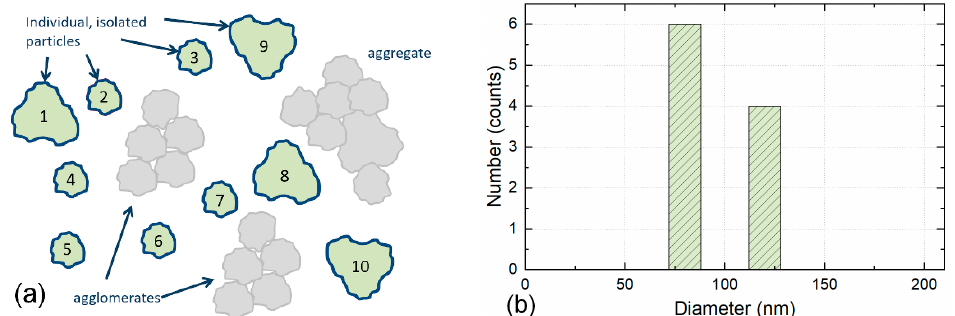
Figure 2. Illustration of Counting Rule 1. ( a ) The particles 1 to 10 are individual particles, without an internal structure that could identify them as agglomerates or aggregates. Only those 10 particles are counted, agglomerates and aggregates (grey) are excluded. ( b ) For the sake of illustration, we assume here only two different types of individual particles, with a size of 80 nm (particles numbered 2 to 7) and 120 nm (particles number 1, 8, 9 and 10). The height of the two columns in the histogram reflects the number of particles of the two sizes 80 nm (6 particles) and 120 nm (4 particles). The width of the columns has no quantitative relevance and is only illustrative.